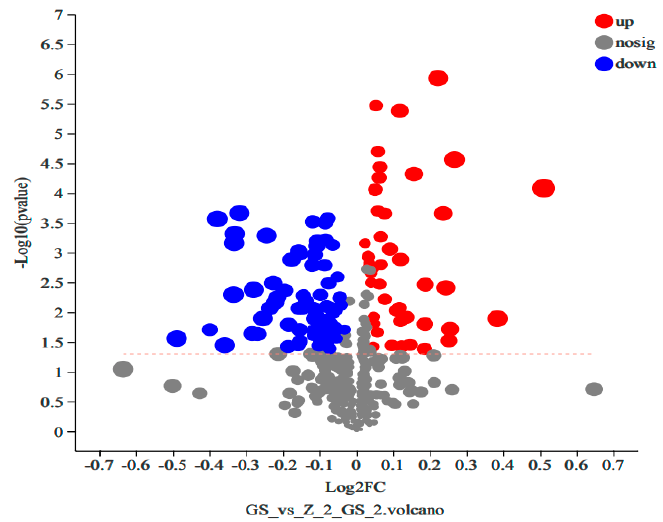
Figure 4. Metabolite volcano map of the Z-2-GS-2 group vs. The GS group. Note: the GS group represents Vigna angularis without the spraying of FSA; the Z-2-GS-2 group is Vigna angularis under FSA stress. The abscissa is the fold change value of the metabolite expression difference between the two groups that is, log 2 FC, and the ordinate is the statistical test value of the metabolite expression difference, that is, the − log10 ( p -value) value. The higher the value, the more significant the expression difference. Each point in the figure represents a specific metabolite, and the size of the point represents the VIP value. The point on the left represents the metabolite with a downregulated expression difference, and the point on the right represents the metabolite with an upregulated expression difference. The significant the expression difference is between the left and right sides and the upper